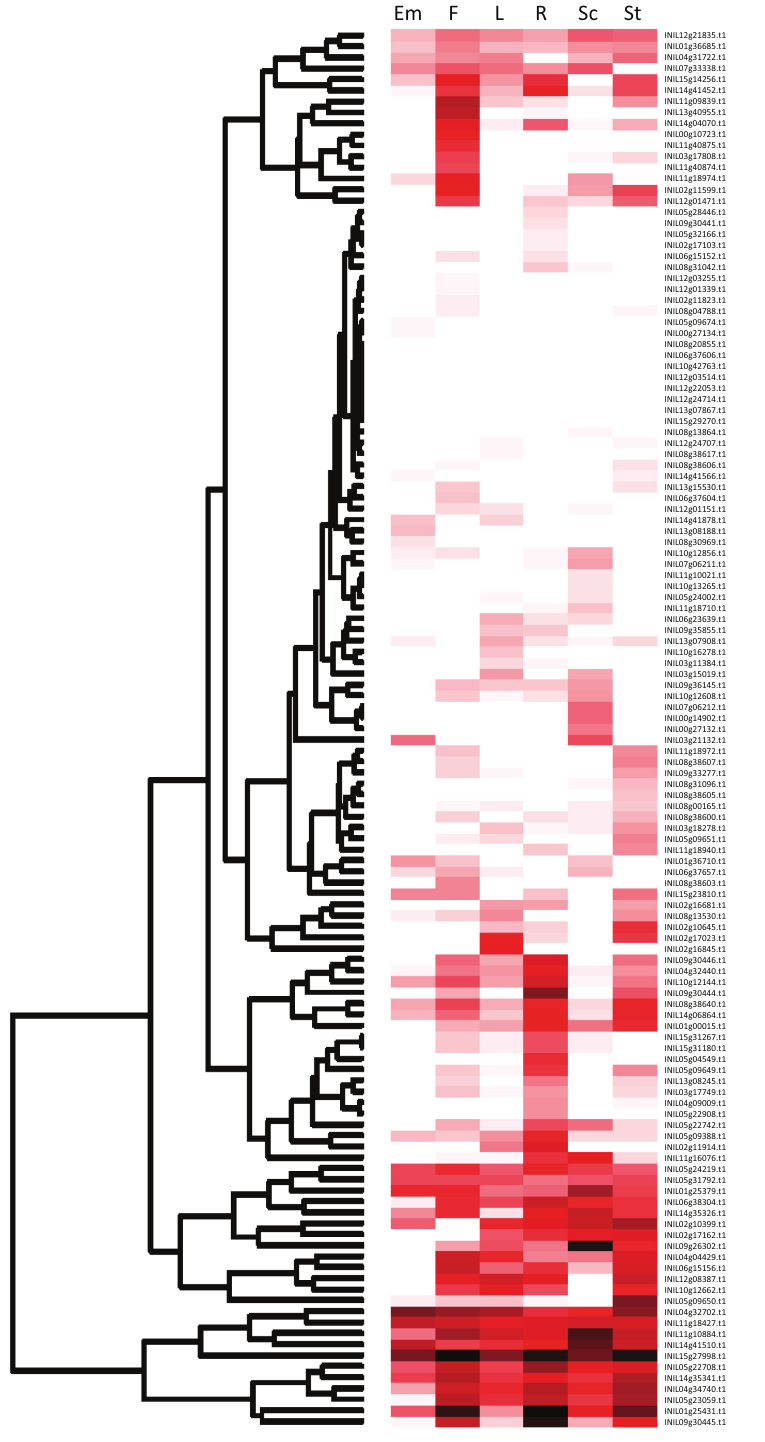
Fig 5. Gene expression profile of the R2R3-MYBs in Japanese morning glory. Gene expression data for various organs of Japanese morning glory was obtained from Ipomoea nil RNA-seq database